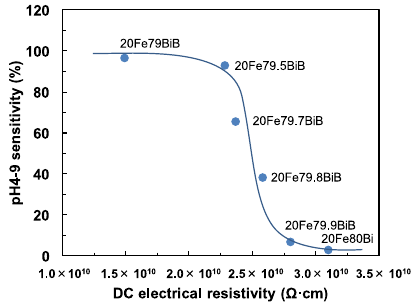
Figure 3. Relationship between pH4 ‐ 9 sensitivity and DC electrical resistivity for 20Fe y BiB glasses. Table 1. DC electrical resistivity, pH4 ‐ 9 sensitivity, pH response time and contact angle for 20Fe y BiB glasses and related glasses.